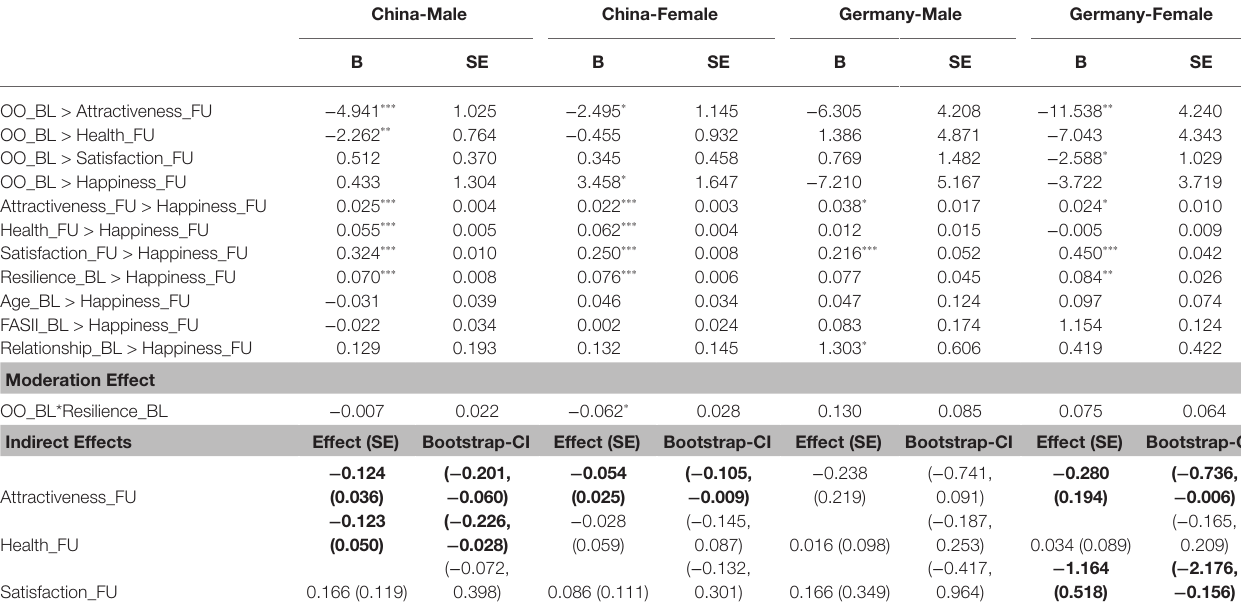
TABLE 3 | Summary of mediated and moderated regression analyses predicting